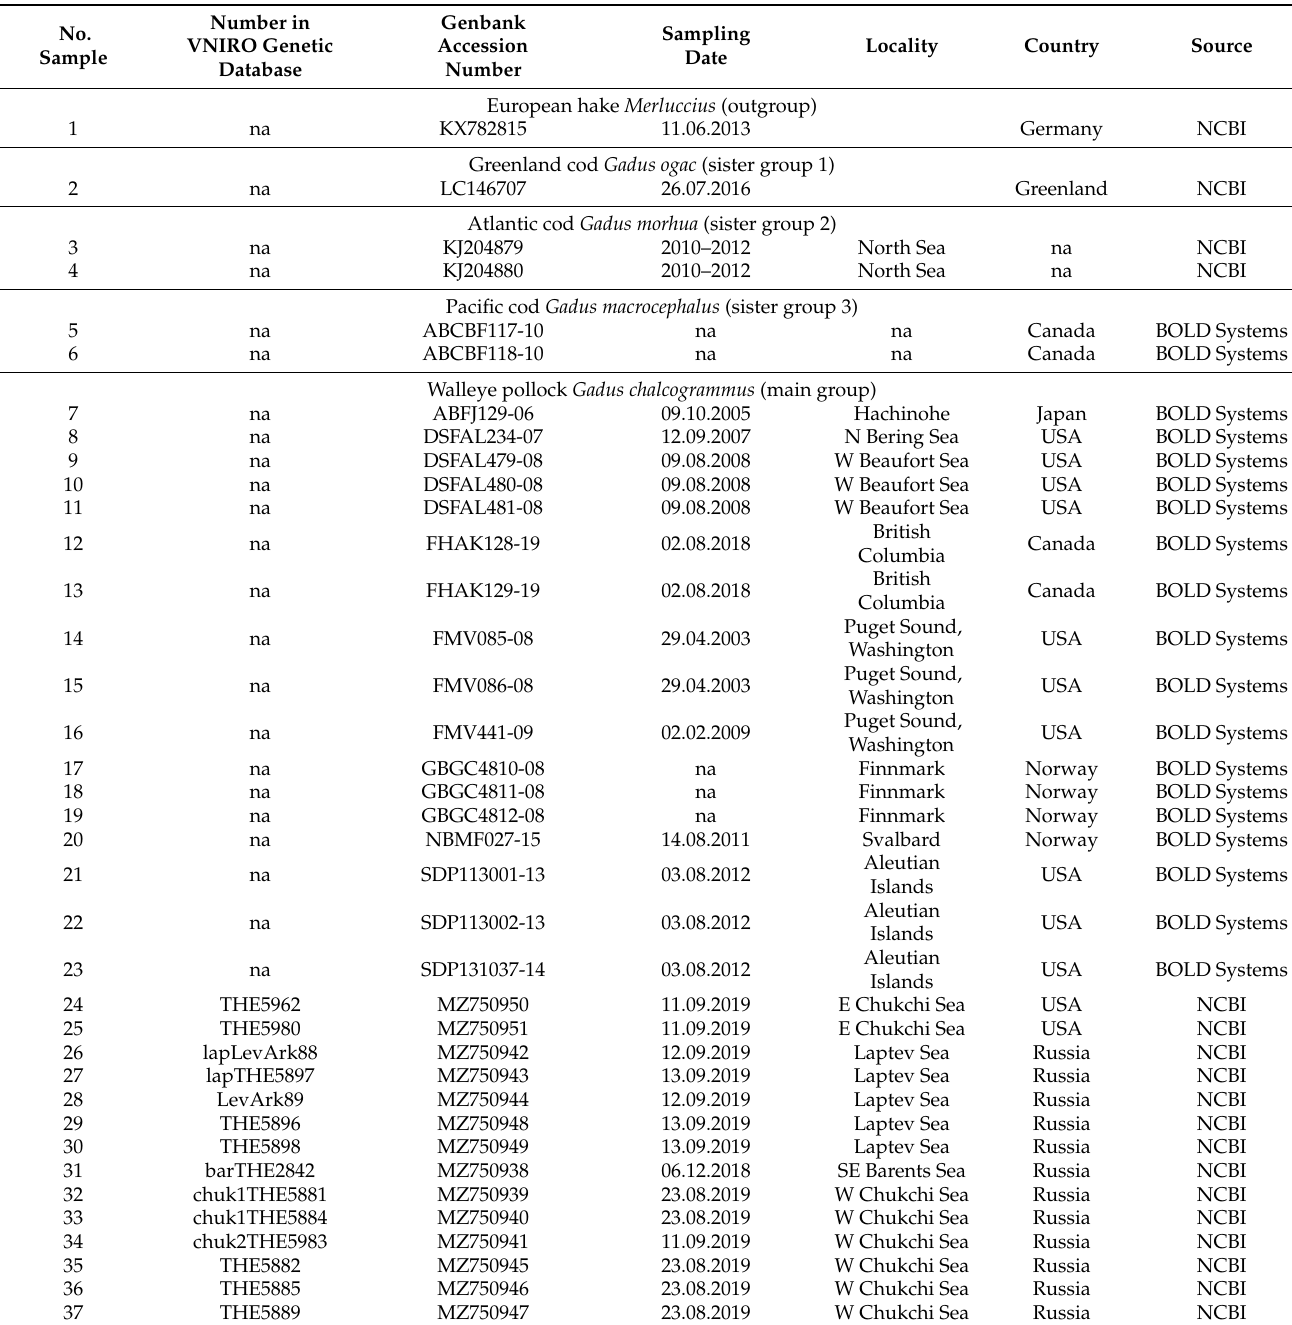
Table 2. Information about CO1 sequences and respective samples used for genetic analysis to identify walleye pollock Gadus chalcogrammus from various areas of species’ range, its congeners and outgroup (na = not available). No.